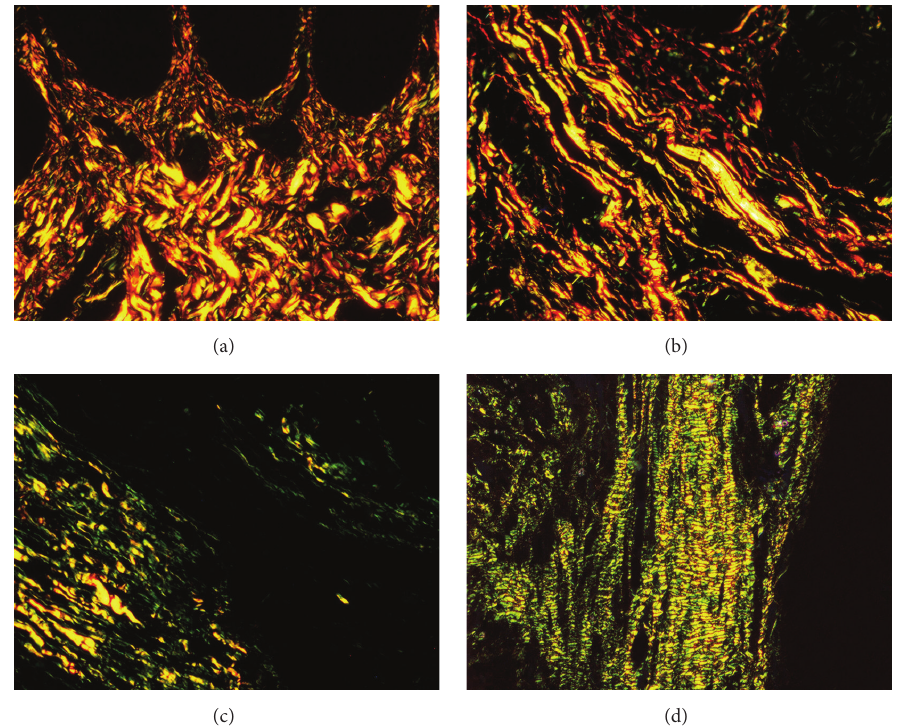
Figure 2: Photomicrograph of PSR stained sections under polarized light microscopy (20x). (a) NM showing YO birefringence. (b) WDSCC showing predominantly YO birefringence. (c) MDSCC showing YO to GY birefringence. (d) PDSCC showing predominantly GY